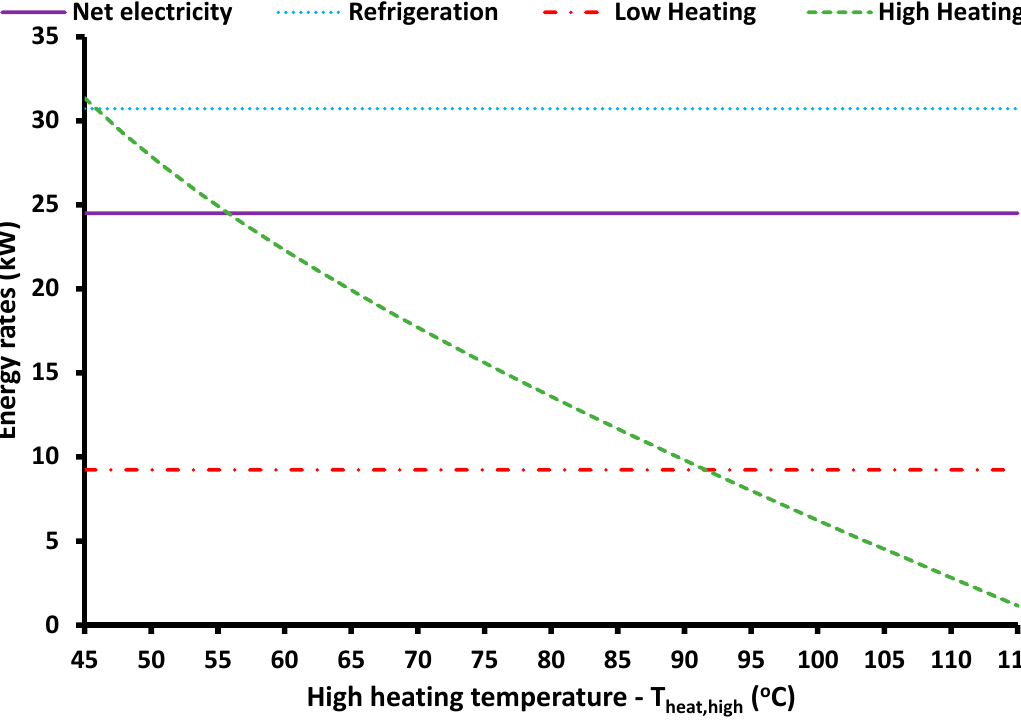
Figure 16. Useful energy products for different values of the high heating temperature.